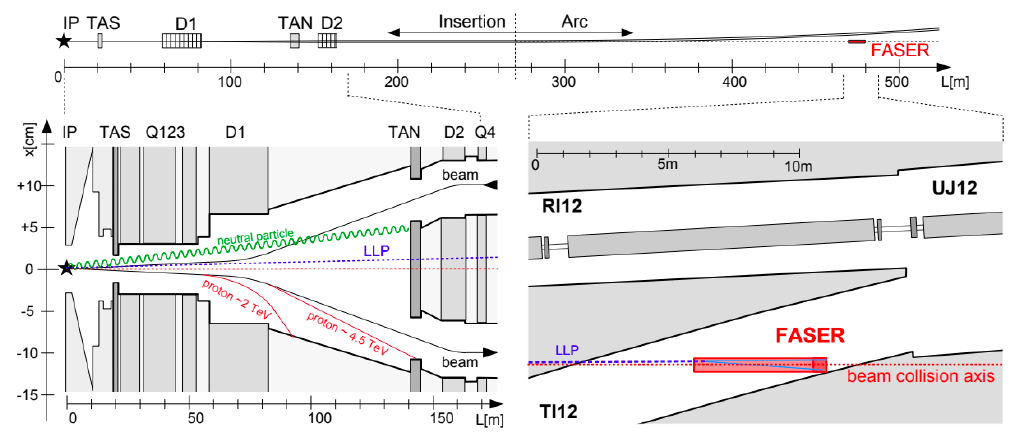
Figure 2 . The scheme of the FASER experiment. The (cid:12)gure from [66]. Phase L , fb (cid:0) 1 L [m] R [m] l [m] (cid:18) faser [rad] det FASER 150 480 0.1 1.5 2 : 1 (cid:1) 10 (cid:0) 4 FASER 2 3000 480 1 5 2 : 1 (cid:1) 10 (cid:0) 3 FASER 2 3000 480 1.5 5 3 : 1 (cid:1) 10 (cid:0) 3 (alternative con(cid:12)guration) Table 1 . Parameters of the FASER experiment. Prototype detector (FASER) is approved to collect data during the LHC Run 3. FASER 2 is planned for HL-LHC phase, but its con(cid:12)guration is not (cid:12)nalized yet. In the third line, we propose an alternative con(cid:12)guration of FASER 2 that would allow drastically increasing its reach towards the scalar portal. L is the integrated luminosity of the corresponding LHC run. L is the distance between the ATLAS interaction point and the entrance of the FASER decay vessel. R is the radius of the decay vessel. l det is the length of the detector and (cid:18) FASER = R=L is the angle, so that the solid angle subtended by the detector is given by (cid:10) faser = (cid:25)(cid:18) 2 faser . For our investigation, we assume that the decay vessel is a cylinder, centered around the beam